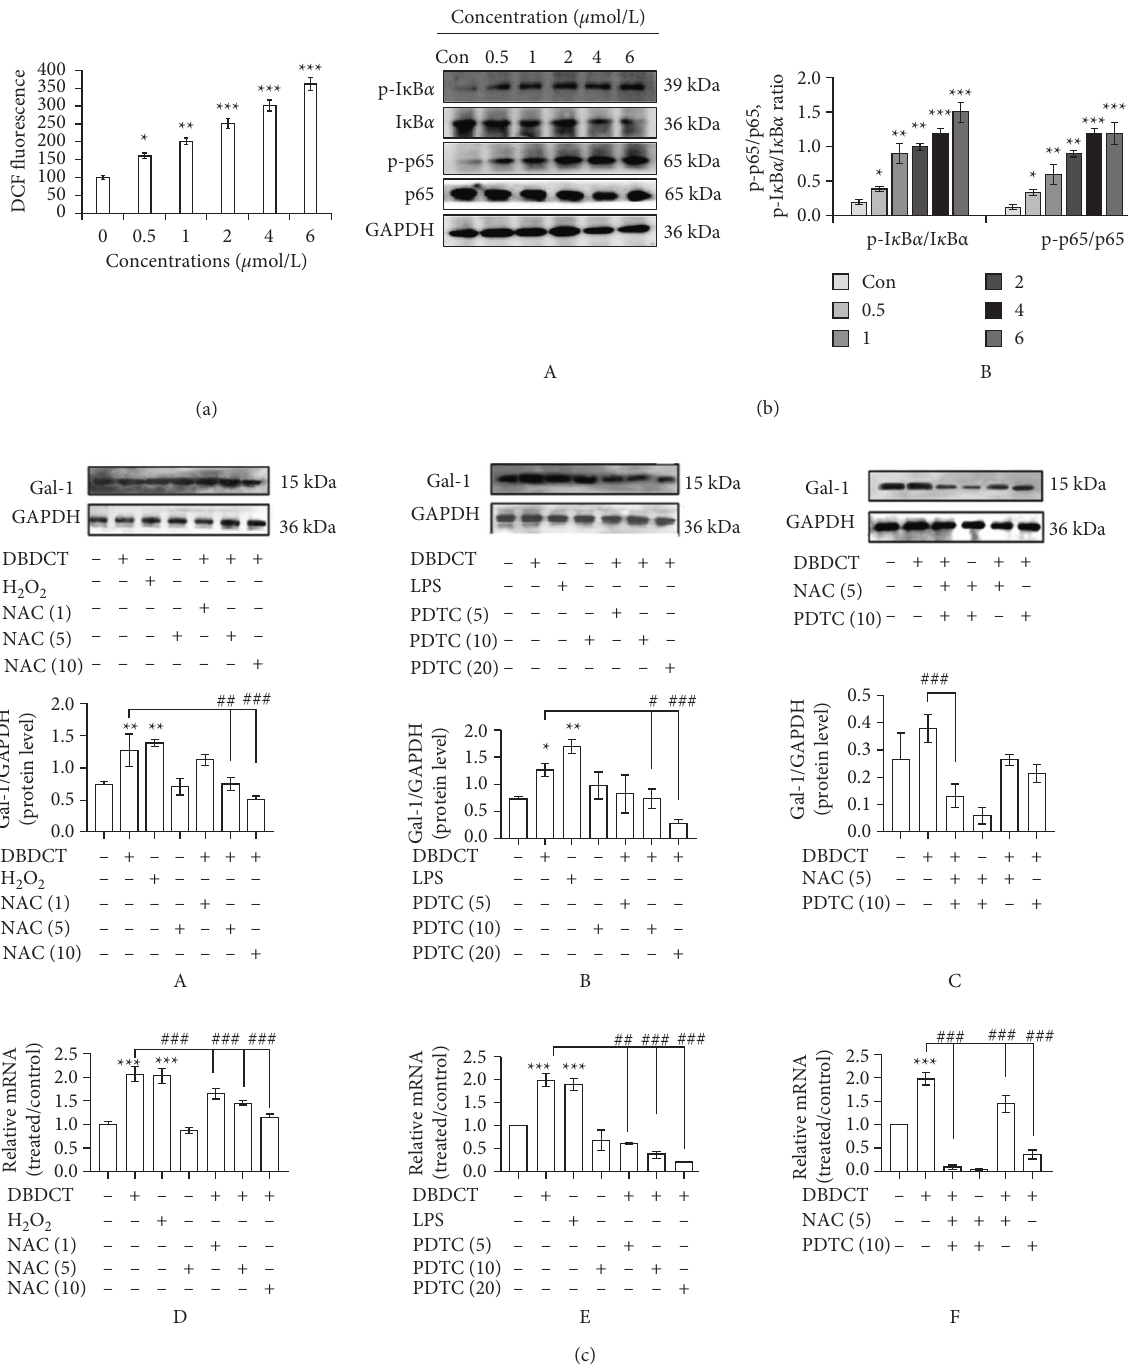
Figure 6: Effects of DBDCTon ROS generation and NF- κ B activation with different concentrations for 24h and effects of NAC (inhibitor of ROS) and PDTC (inhibitor of NF- κ B) on the expression of Gal-1 induced by DBDCT in HL7702 cells. (a) ROS generation. (b) NF-kB activation. (c) Effects of inhibitor on the expression of Gal-1 induced by DBDCT (2 μ mol/L). (A) (D) Effects of NAC (1, 5, and 10 μ mol/L) on Gal-1 protein and mRNA level. (B) (E) Effects of PDTC (5, 10, and 20 μ mol/L) on Gal-1 protein and mRNA level. (C) (F) Effects of the combination of NAC (5 μ mol/L) and PDTC (10 μ mol/L) on Gal-1 protein and mRNA level. Results were normalized according to GAPDH level. Each value represents the mean ± SD of three independent experiments. ∗ p < 0 . 05, ∗∗ p < 0 . 01, and ∗∗∗ p < 0 . 001 compared with the control. # p < 0 . 05, ## p < 0 . 01, and ### p < 0 . 001 compared with the DBDCT